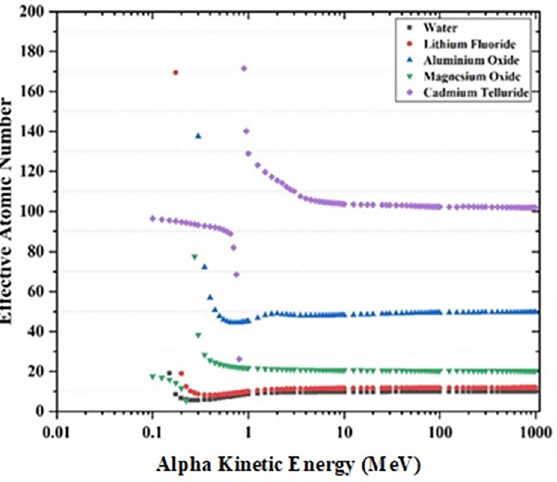
Figure 2. Variation of Z eff with kinetic energy of Alpha for water, lithium fluoride, aluminum oxide, magnesium oxide and cadmium telluride. At low energies the effective atomic number is close to the number of electrons in molecular unit of compound.